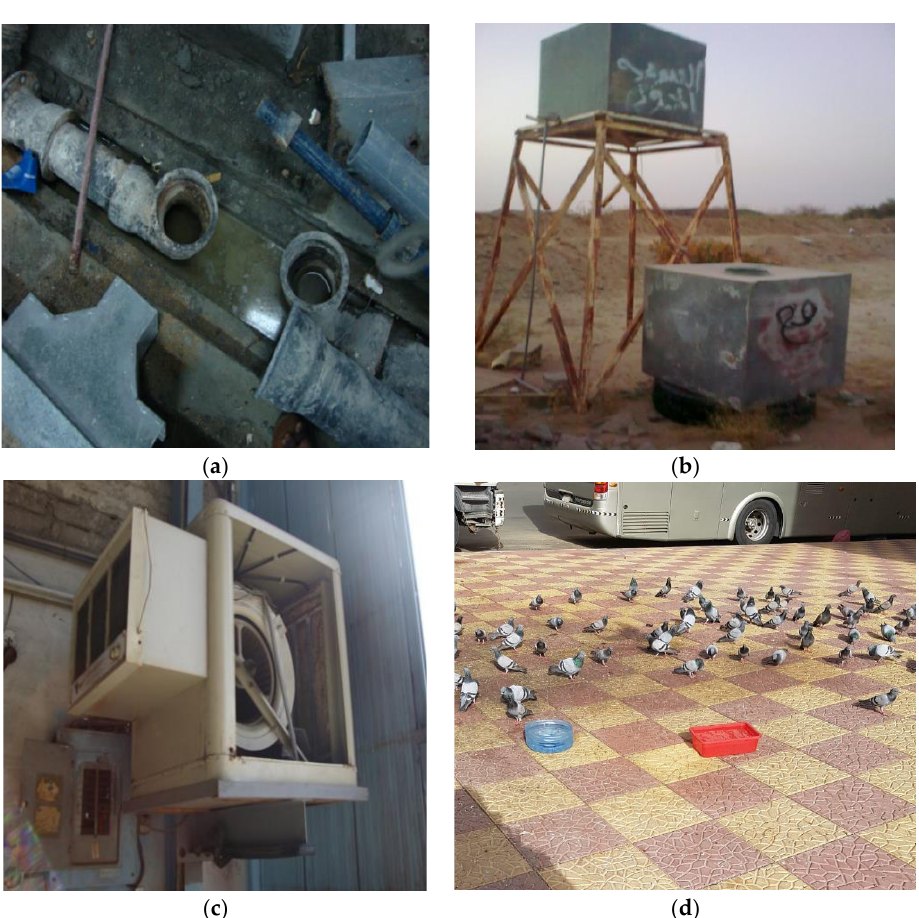
Figure 1. Field photos and examples of potential breeding sites for Aedes aegypti . ( a ) Construction site, ( b ) uncovered water tanks, ( c ) air conditioner, and ( d ) bird drinking containers.